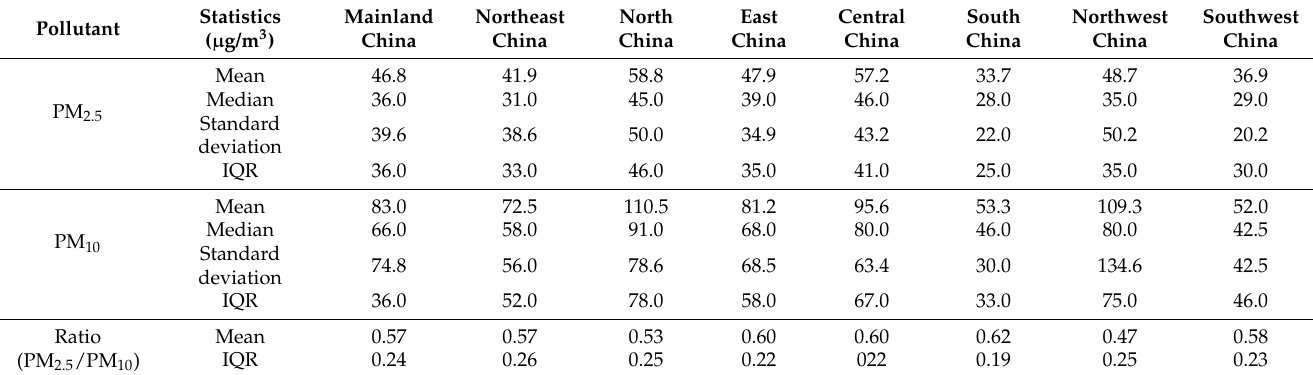
Table 1. Mean and regional means of PM 2.5 and PM 10 for 2015–2018 in mainland